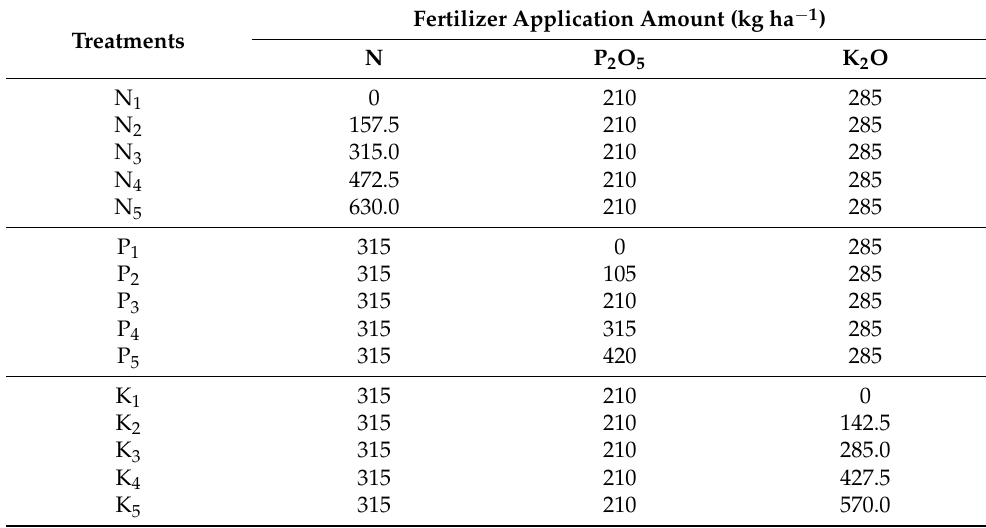
Table 1. Nutrient application amounts for all the treatments in the field trials of Lactuca sativa L. during the growth